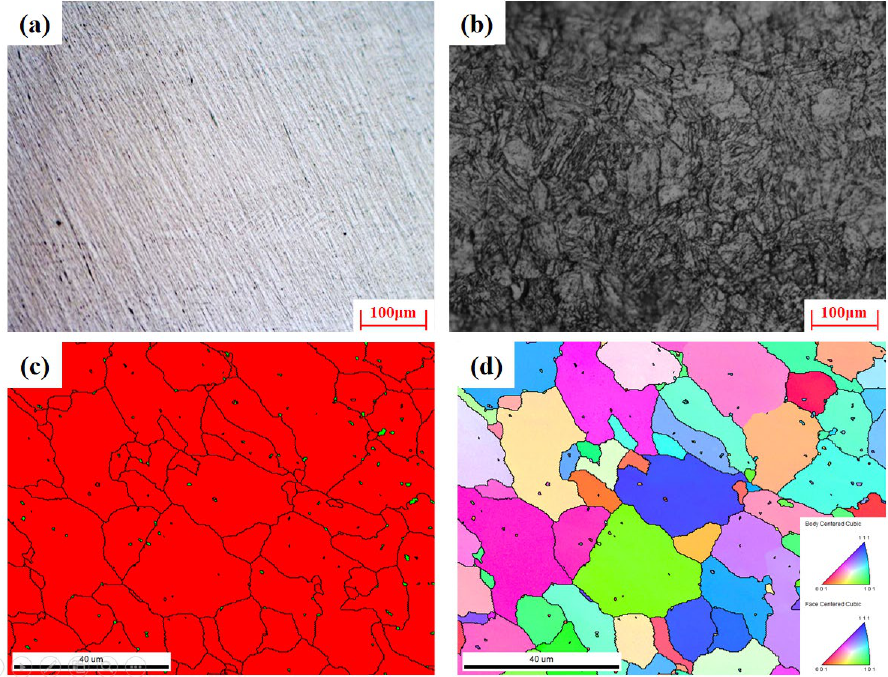
Figure 3. Optical micrographs and EBSD data revealing the ( a ) cyclic oxide of the studied material, ( b ) typical micro-structures of 13Cr110, ( c ) grain boundaries in 13Cr110, and ( d ) inverse pole map of 13Cr110.